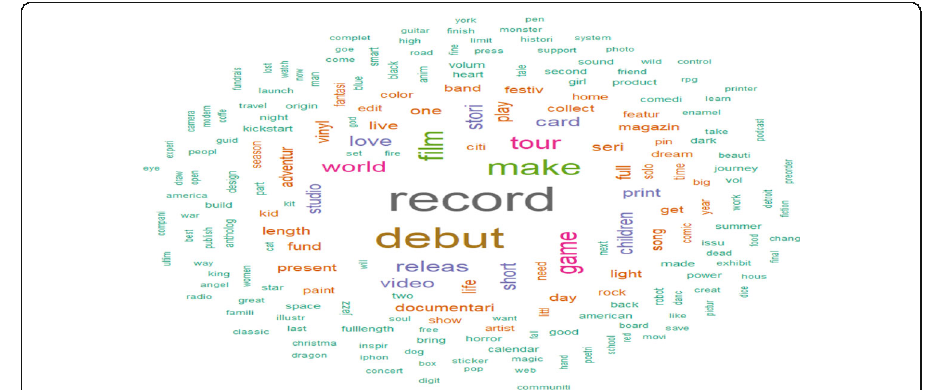
Fig. 10 Word cloud showing the most popular words in a successful